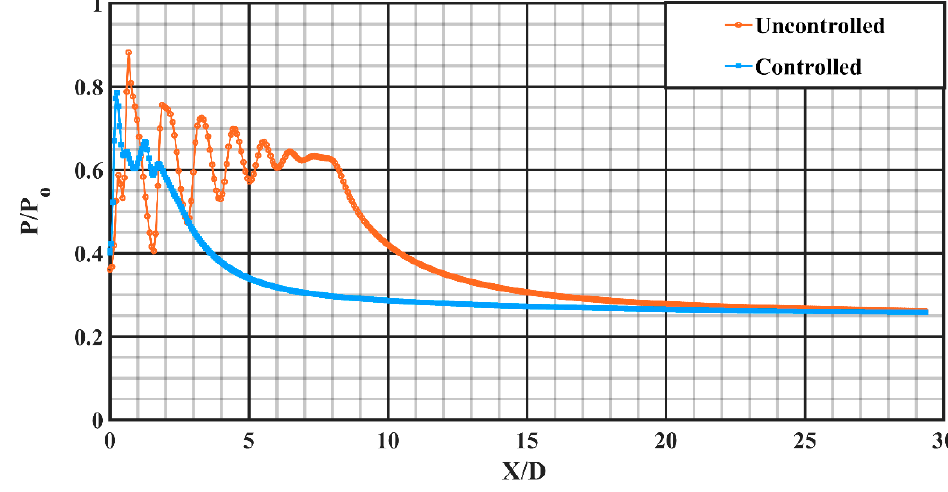
Figure 11. Decay of Jet centerline pressure for Mach 1.8 at NPR 4.